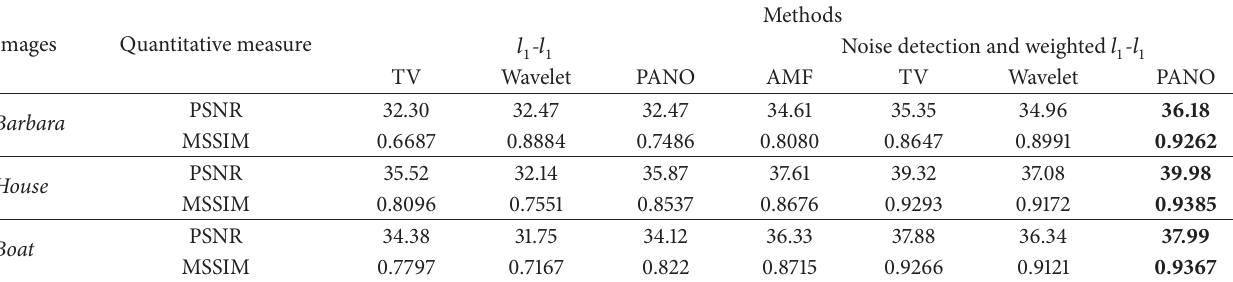
Figure 11: Quantitative measures versus the weight for noise candidates. Note: House image with 70% salt and pepper impulse noise is used in simulation and 𝜆 is 2.6. Table 1: Quantitative measures for 50% salt and pepper impulse